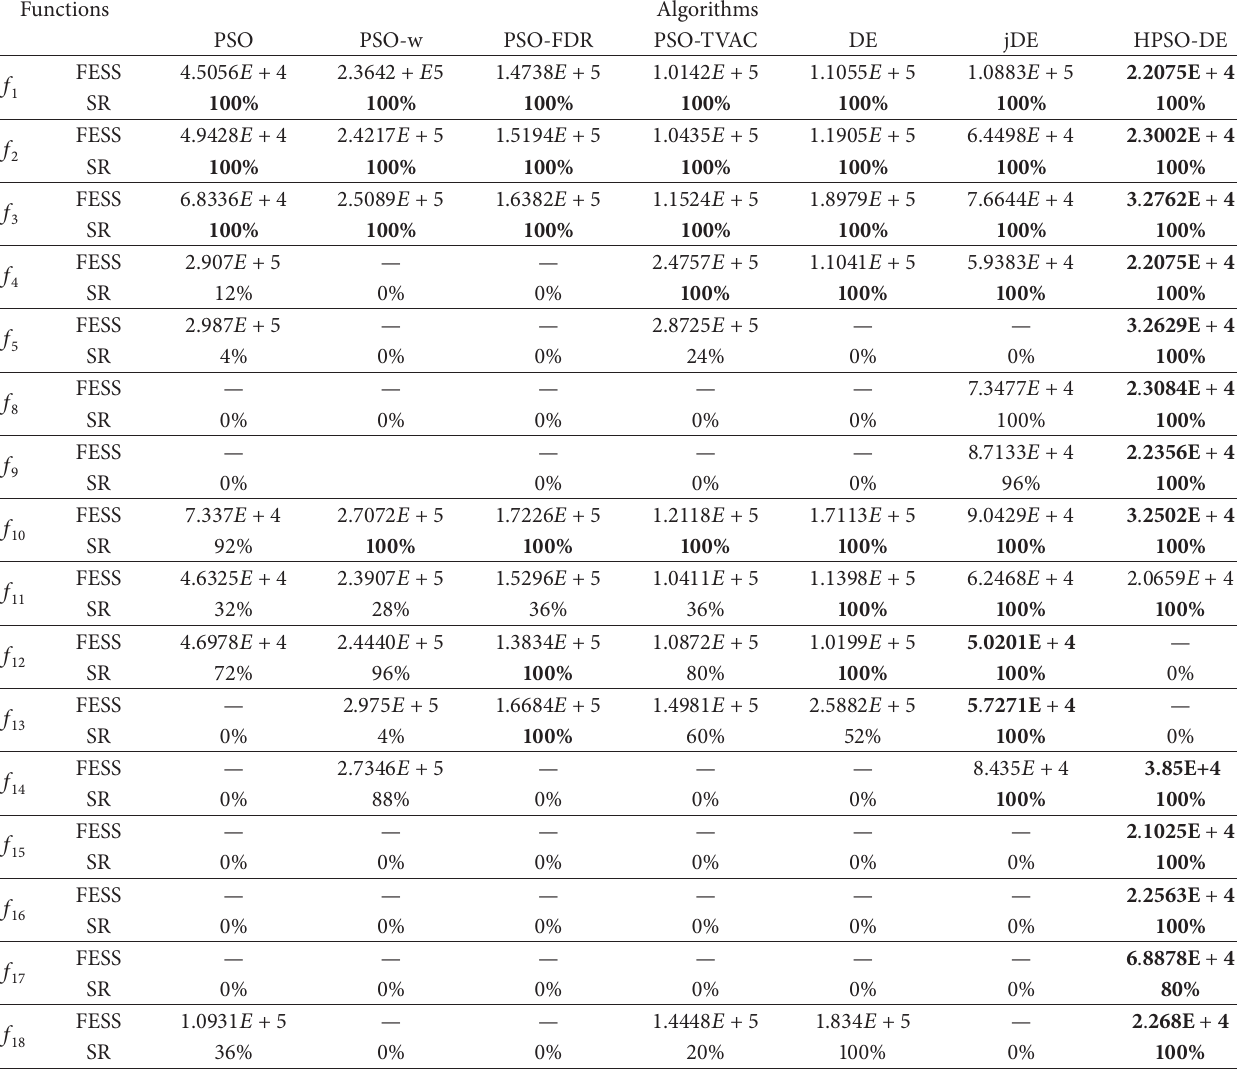
Table 4: Convergence speed and algorithm reliability